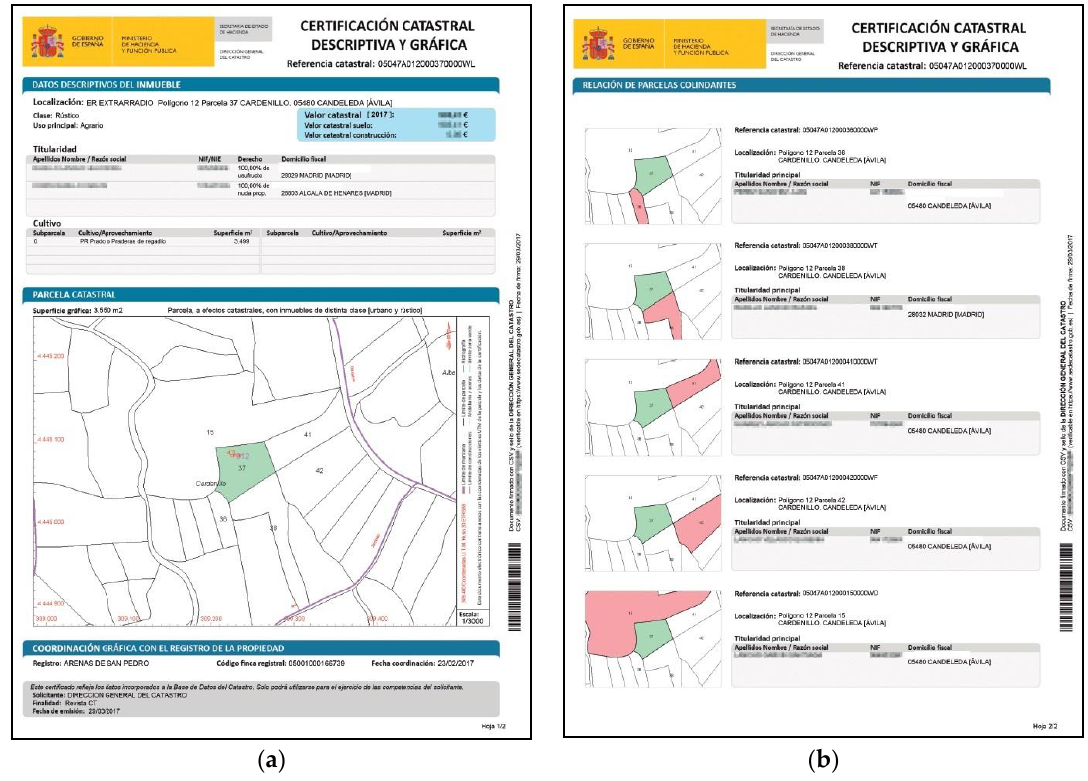
Figure 3. Descriptive Cadastral and Graphic Certification (CCDG) of a cadastral parcel according to the design 11 November 2016. Front ( a ) and back ( b ) Source: